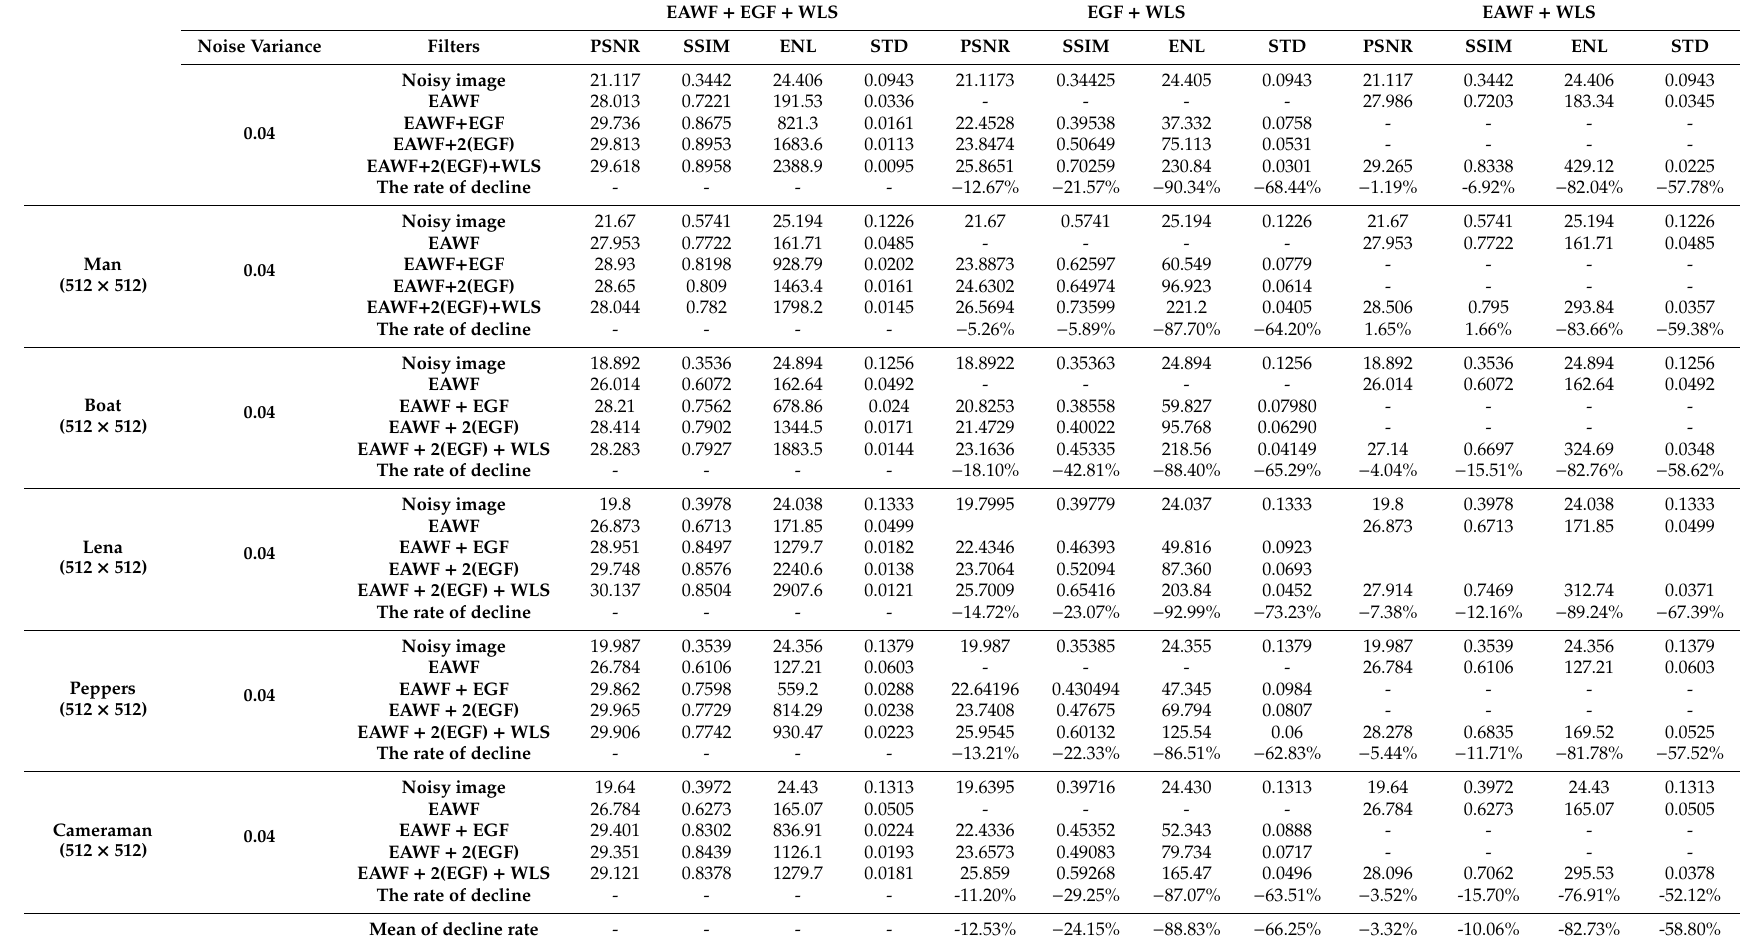
Table 2. The sub-filters performance of the proposed